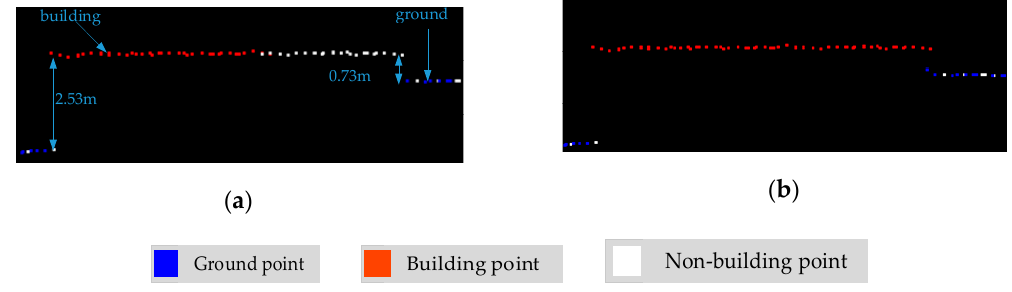
Figure 4. Profile of a building located on a slope. ( a ) Before restricted region growing; ( b ) After restricted region growing.